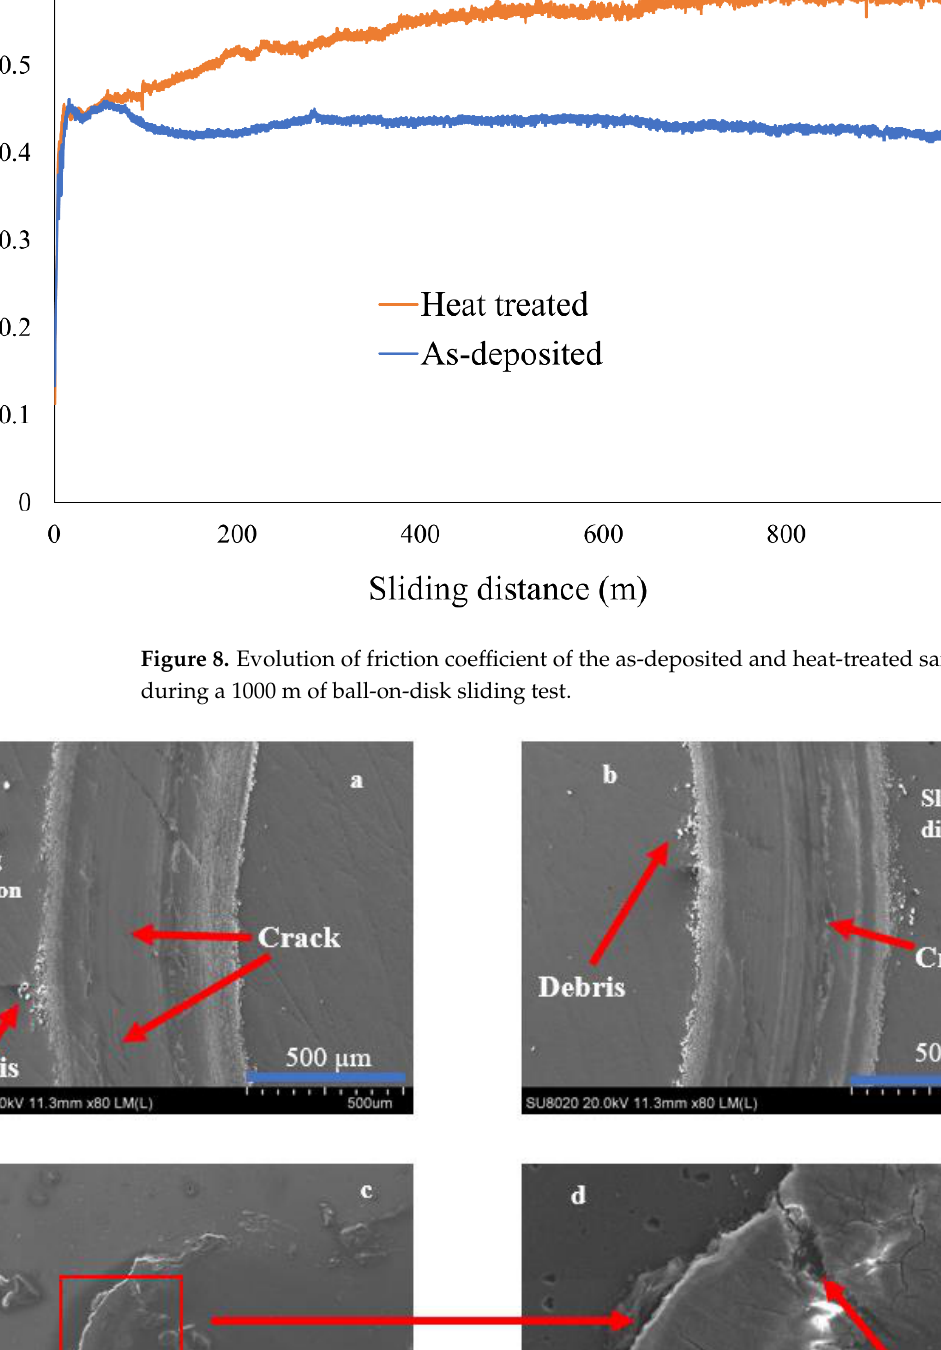
Figure 9. ( a , b ), SEM micrographs of the wear tracks from the heat-treated electroless nickel boron; ( c , d ), surface of the alumina balls after the dry ball-on-disk sliding test.